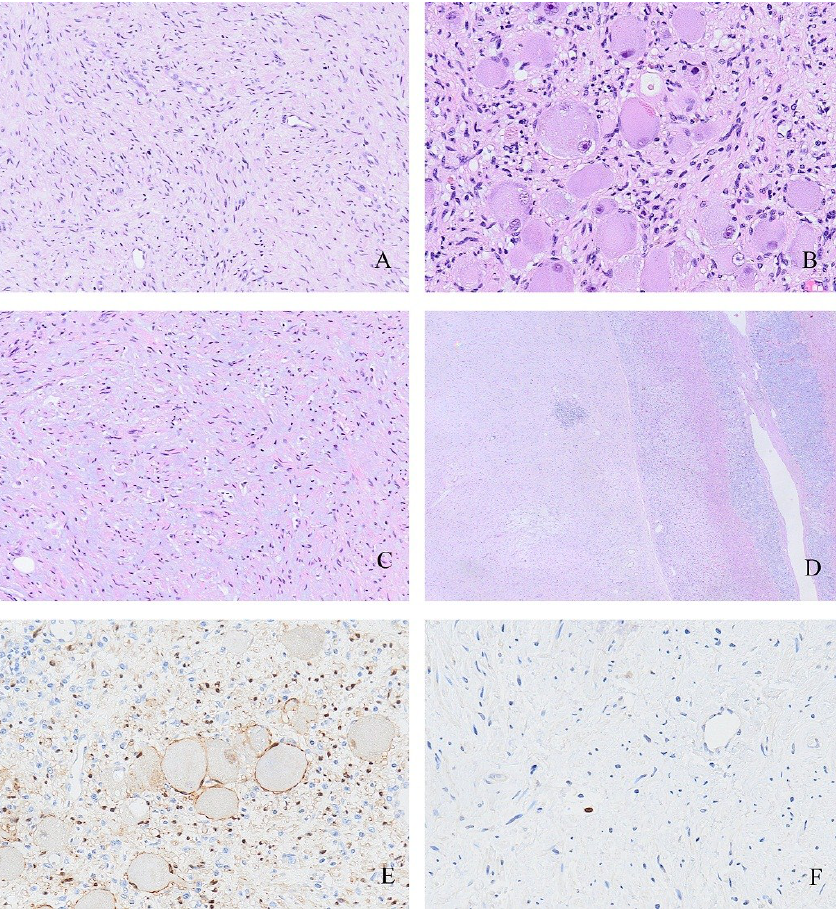
FIGURE 3. Histologic sections of the extra-adrenal retroperitoneal GN. The tumor was composed of nerve fibers (A) and mature ganglion cells (B) without any malignant features. (C) Myxoid degeneration of neuromatous stroma. (D) The tumor was clearly separated from the adrenal gland. (E) Immunopositivity for S100 was observed in ganglion and Schwann cells. (F) Ki-67 expression was